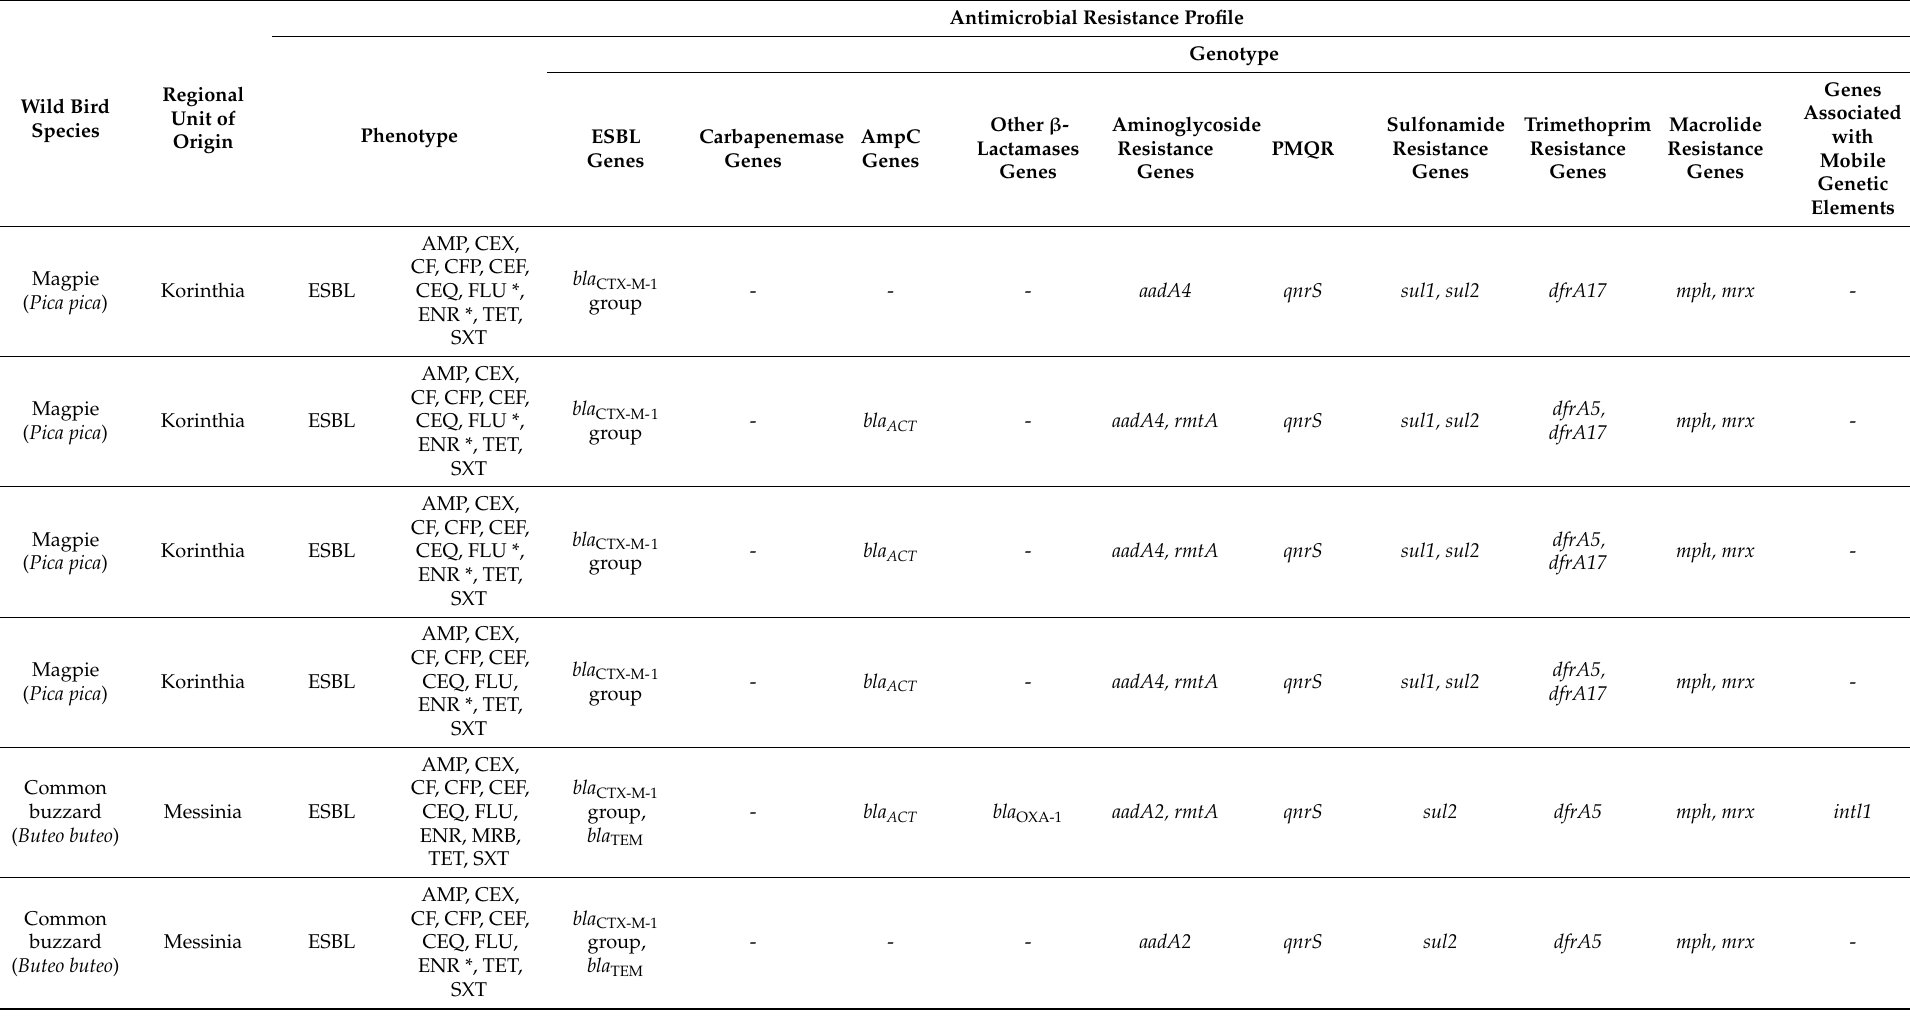
Table 2. Characteristics of the ESBL- and the Carbapenemase-Producing E. coli